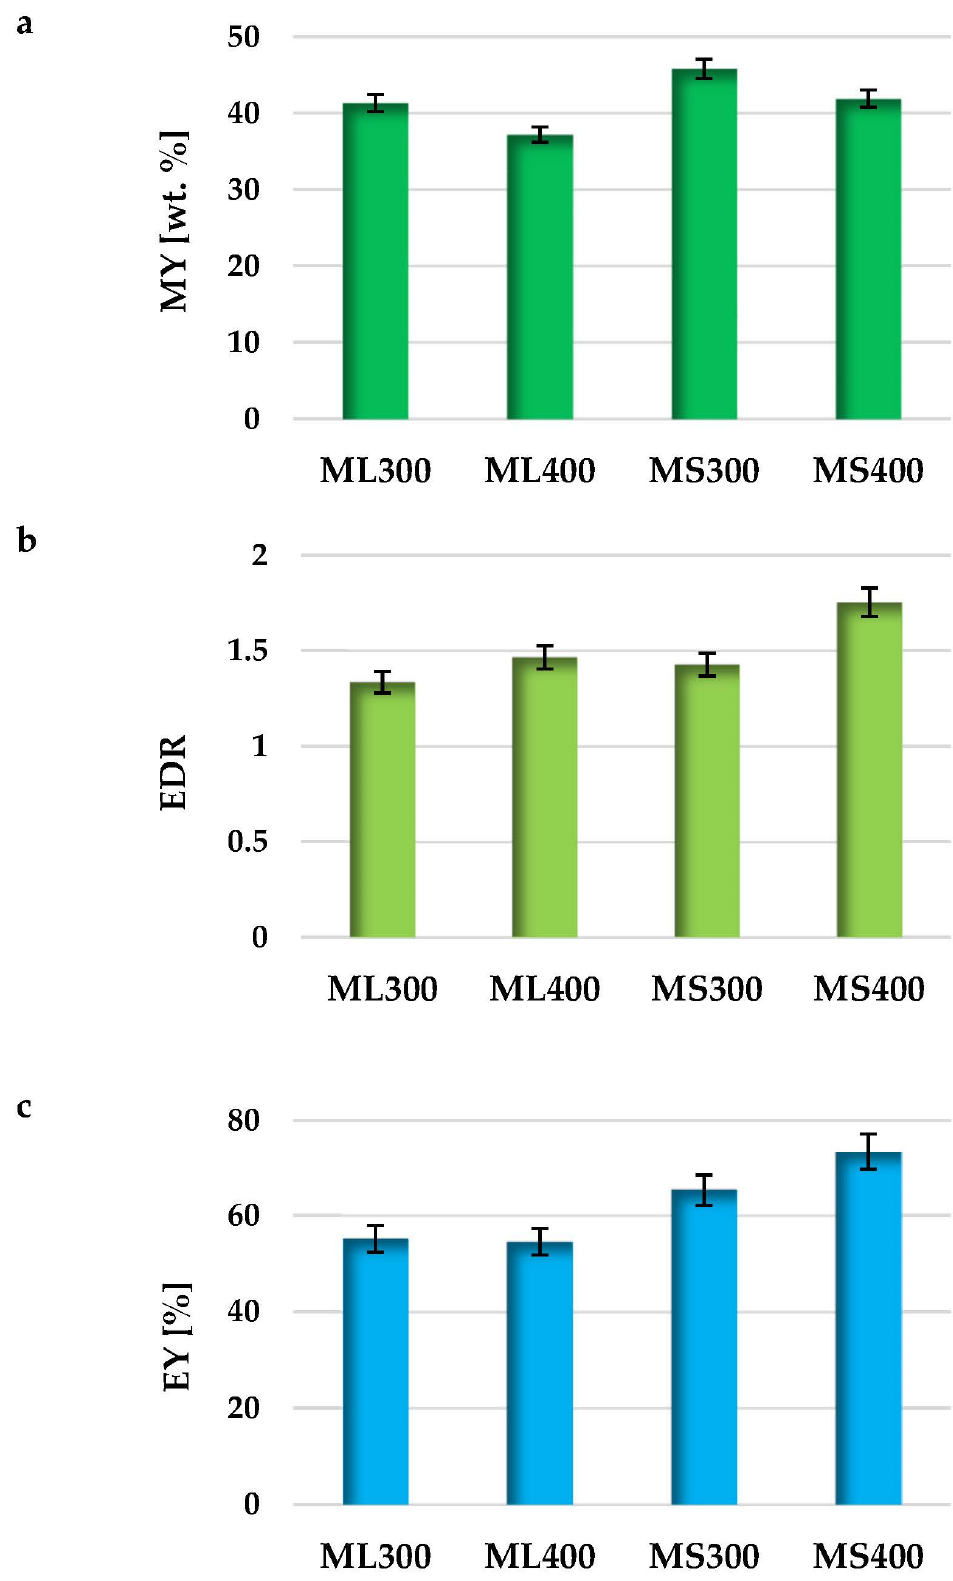
Figure 6. The mass yield of pyrolysis process ( a ), energy densification ratio ( b ) as well as energy yield ( c ) of the biochars prepared.